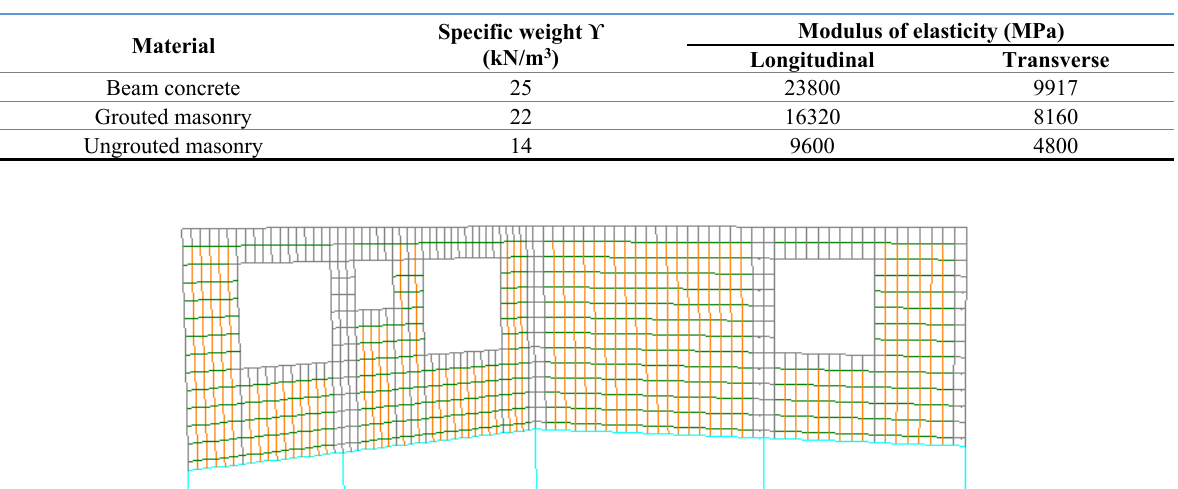
Table 1. Physical properties of the materials used in modeling [5].